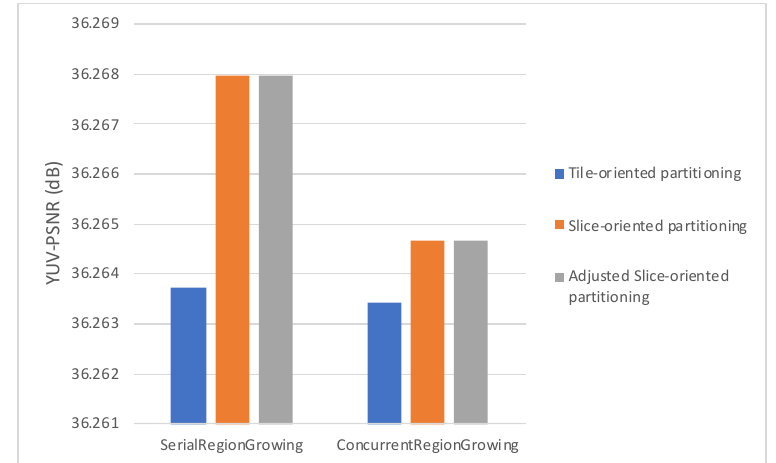
Figure 13. Average bitrate performance for 7 regions.